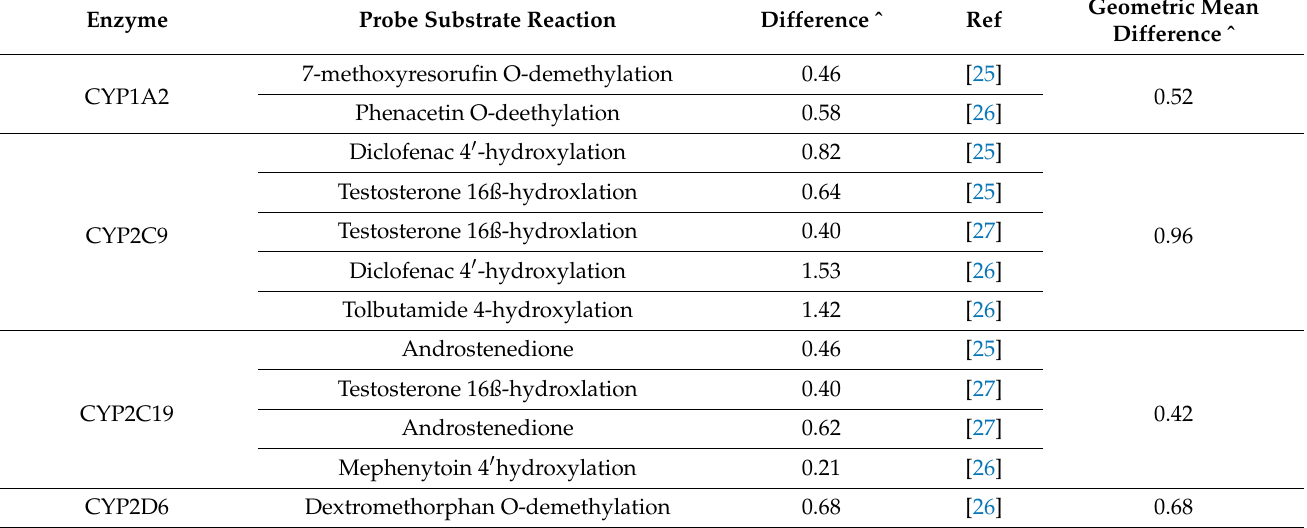
Table 2. Observed geometric mean differences in the in vitro metabolic activity of cytochrome P450 enzymes in MAFLD versus healthy control